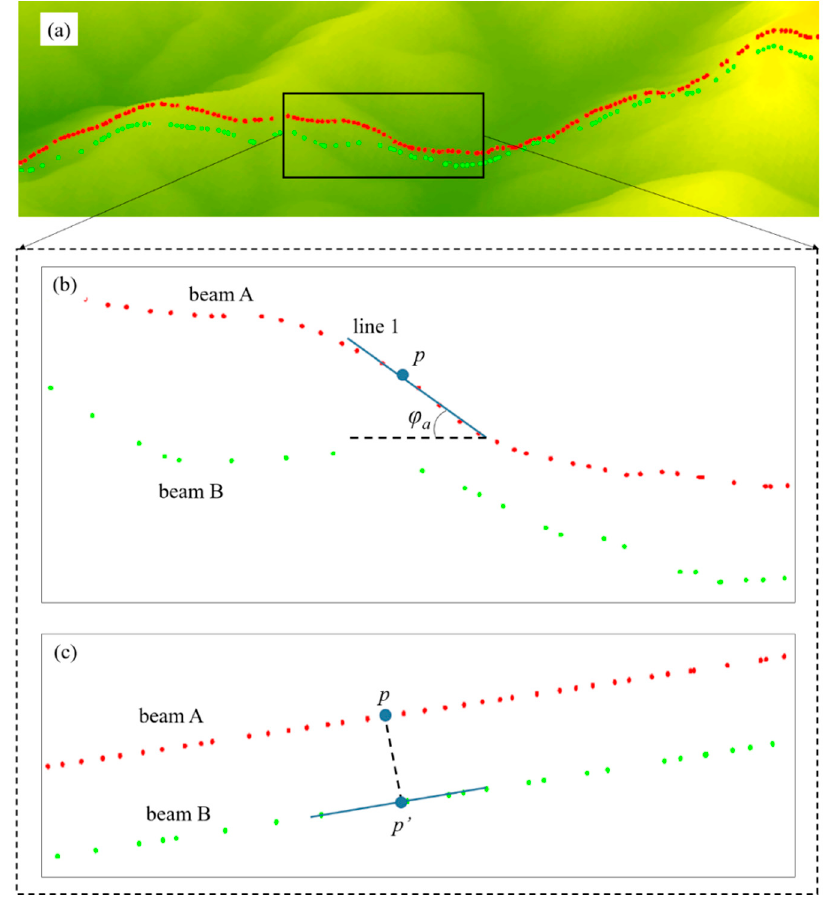
Figure 2. Schematic diagram of slope estimation based on along- and across-track analysis ( a ) three- dimensional distribution of beam pairs; ( b ) side view of beam pairs; ( c ) top view of beam